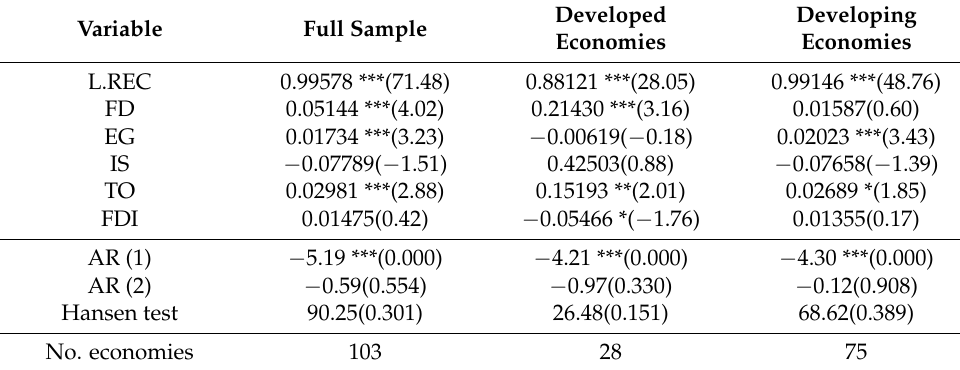
Table 5. Regression results of first level of financial development. Variable Full Sample